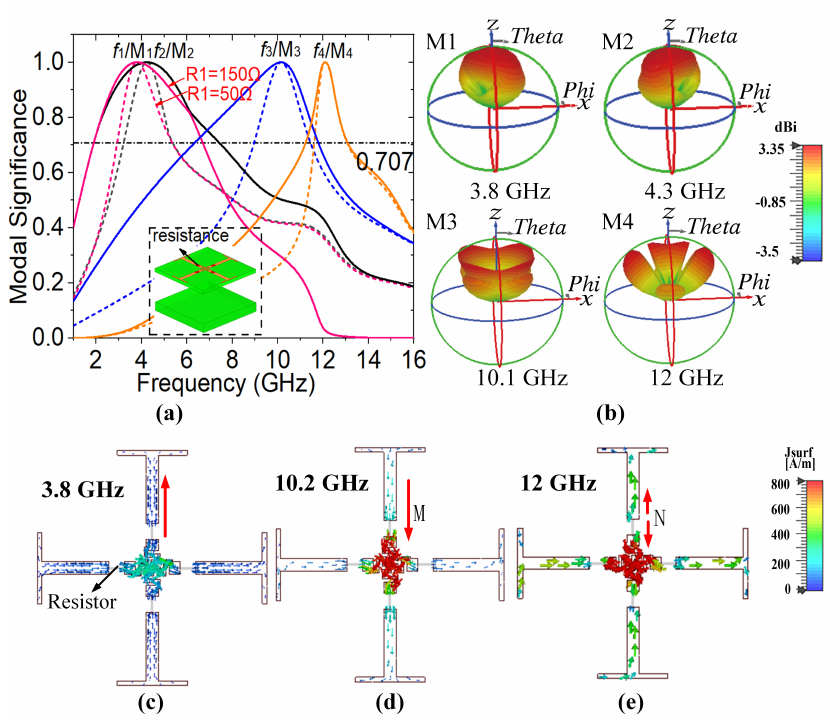
Figure 3. Characteristic mode analysis for the designed absorption structure with R. ( a ) Modal significance with different R. ( b ) Modal radiation patterns with R. ( c ) Mode current at 3.8 GHz; ( d ) mode current at 10.2 GHz; ( e ) mode current at 12.0 GHz.